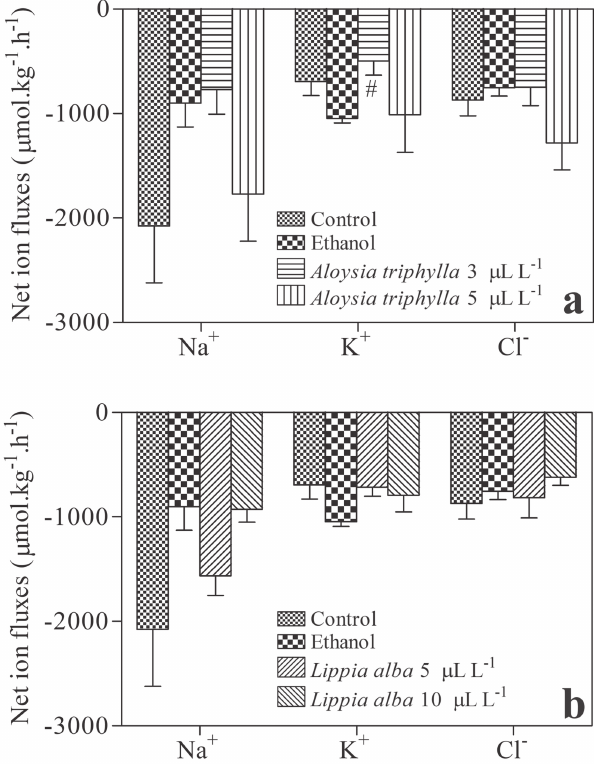
Fig. 3. Net ion fluxes of Serrasalmus eigenmanni exposed to essential oils for 4 hours. a. A. triphylla essential oil. b. L. alba essential oil. # indicates a significant difference from ethanol-exposed fish, based on one-way ANOVA and Tukey tests (P < 0.05).